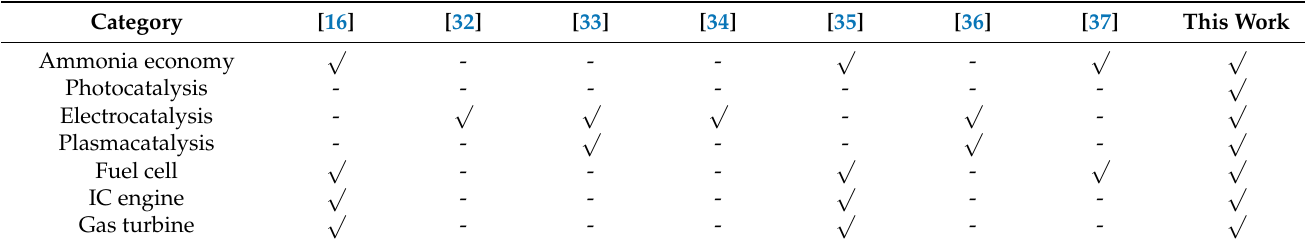
Table 1. The comparison of recent review articles on ammonia as a renewable energy carrier and this work.